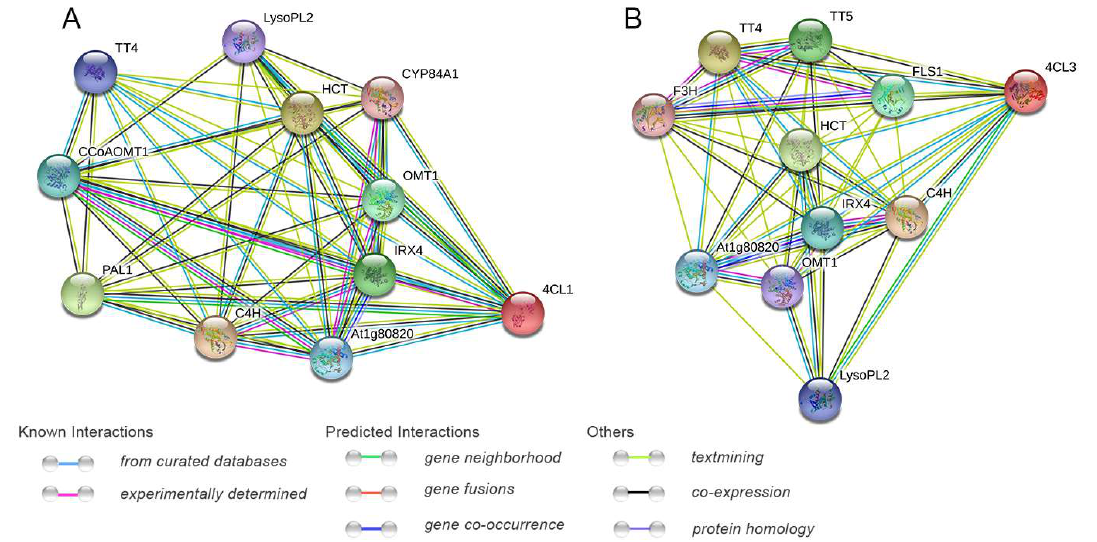
Figure 8. Function interaction network of Pg4CL5 ( A )/Pg4CL2 ( B ) proteins. Note: TT4: chalcone syn-